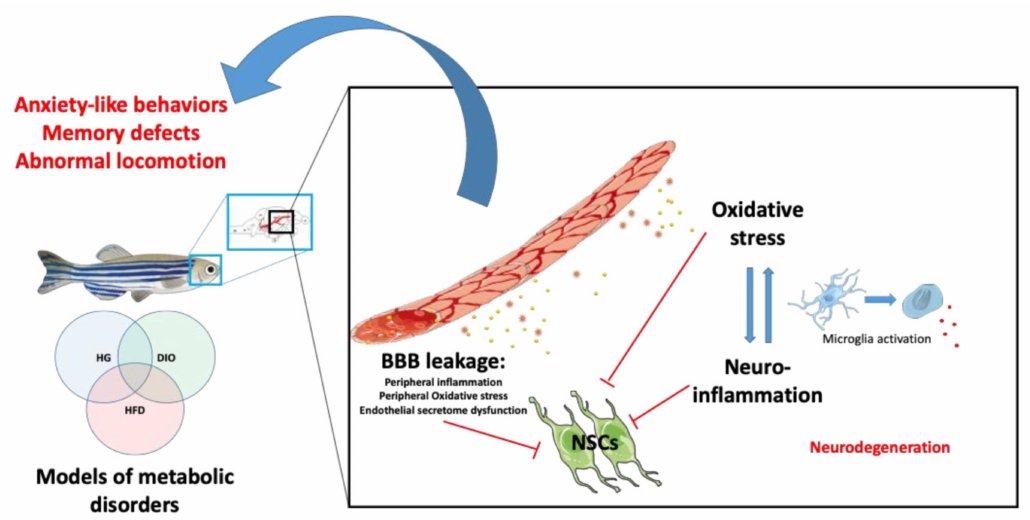
Figure 2. Peripheral and central mechanisms impacting brain homeostasis in metabolic diseases. Under hyperglycemic (HG), DIO and HFD conditions, BBB breakdown occurs and leads to central oxidative stress and neuroinflammation through the activation of microglia (switch from ramified to ameboid state). It can result in neurodegeneration. In addition, metabolic disorders could lead to im- paired secretion of endothelial factors that could, in synergy with the disrupted peripheral and central factors, impair neural stem cell (NSC) activity. The ultimate consequence of such disruptions is the de- velopment of cognitive impairments (locomotion, anxiety, memory) and neurodegenerative